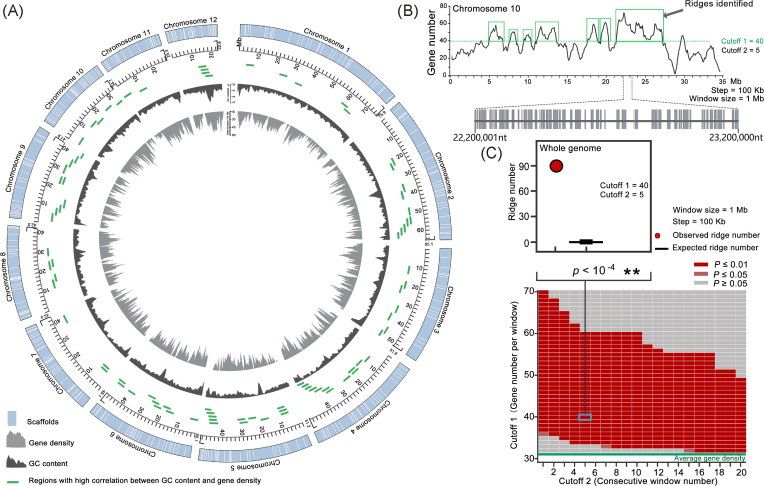
Chromosome-wide gene clustering. (A) Circos shows the assembled chromosomes, GC content, and gene density. The inner scale is 2 Mb. The strips in the outer circle indicate the scaffolds packaged into chromosomes, with each gap (see Fig. 3) replaced with 1 kb of Ns. The inner dark gray ridges show the moving GC percentage, and the inner gray ridges show the moving number of the genes at a window size of 1 Mb. The green sticks indicate the location of the regions with high correlation between GC content with gene density (R > 0.95, P-value < 0.01). (B) Distribution of gene clusters (ridges) on chromosome 10. Curves indicate the moving numbers of genes at a window size of 1 Mb (step = 100 kb). The windows with a maximum gene density from nt 22, 200, 001 to 23, 200, 000 on chromosome 10, which contains 71 genes, are shown in the lower panel. Green boxes highlight ridges in which there are at least five consecutive moving windows with a lower limit of 40 genes per window. (C) Statistical tests of numbers of gene density ridges in the genome corresponding to background noise (null model). The heat map in the lower panel shows P-values in the significance test of observed ridge numbers against the null model ( 10,000 independent permutations of gene positions). The x-axis indicates the cutoff values of numbers of consecutive moving windows, which reflects the extent of the clustering. The y-axis indicates the cutoff values of gene numbers within a certain window size (step 100 kb), which reflects the degree of intensity of the clusters. Green lines represent the average gene number in a certain window size. The upper panel highlights a significance test at the condition of two cutoff values, gene density (40/Mb) and consecutive window numbers (5). Red dots represent the number of observed ridges in the genome. Box plots (black) represent distribution of the ridge numbers in  10,000 independent permutations of gene positions in a random fashion.